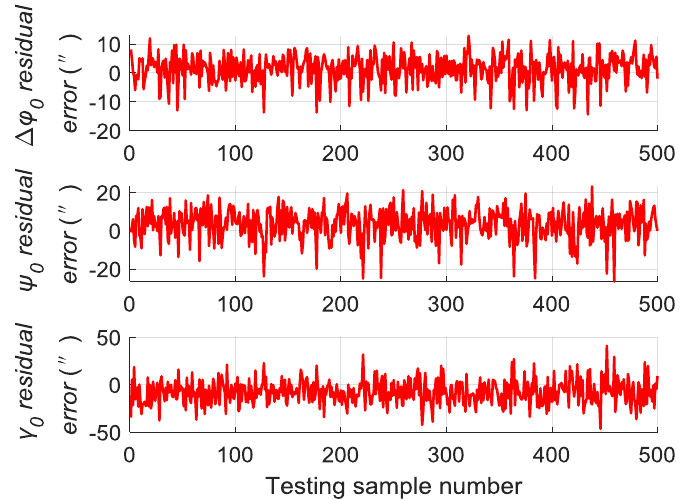
Sensors 2019 , x , x FOR PEER REVIEW Figure 7. Simulation results of initial alignment residual error using RBM-BPNN method.